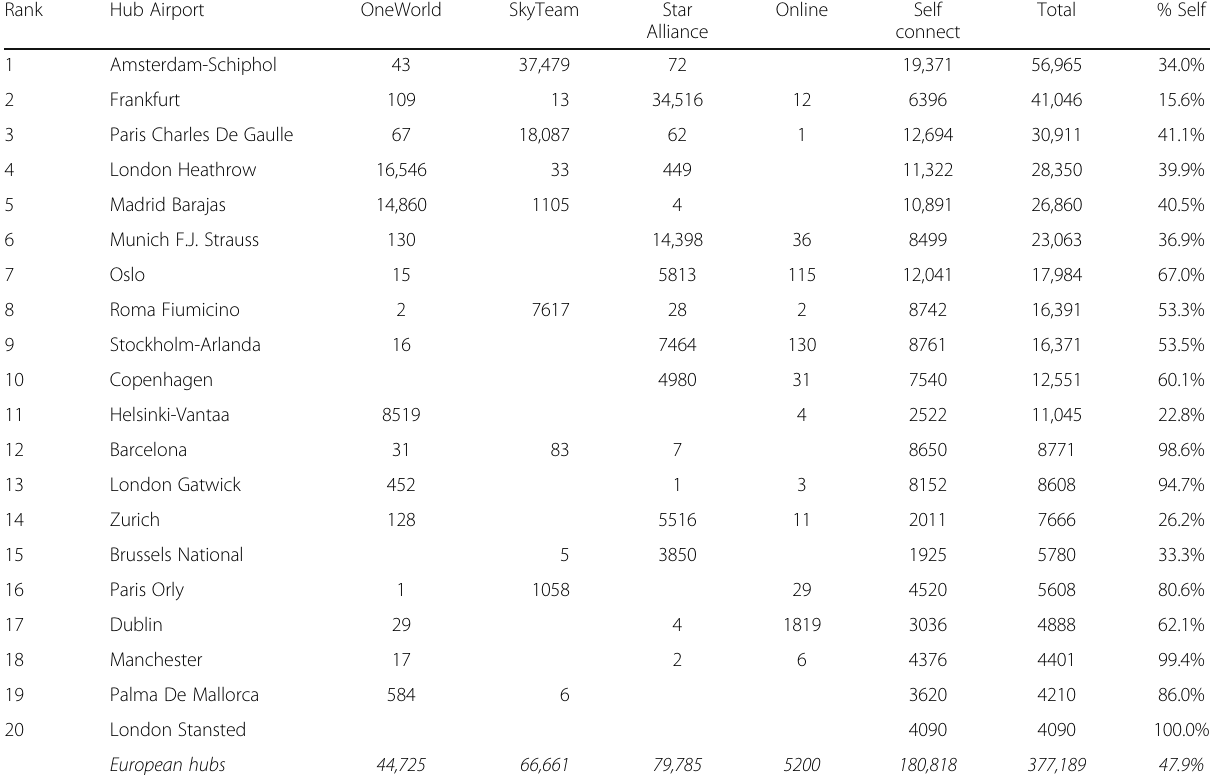
Table 10 First 20 European hubs in terms of the total number of viable connections by